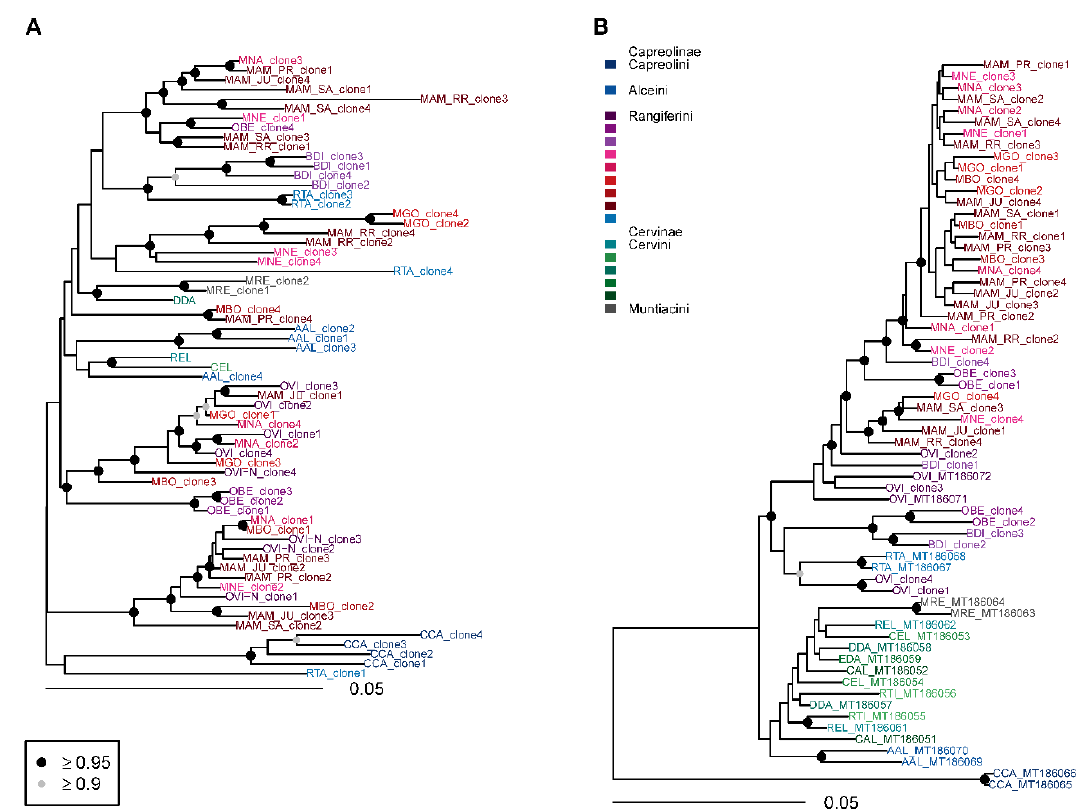
Figure 6. Bayesian phylogenetic trees constructed from cervid satellite sequences. ( A ) SatIII, ( B ) satIV. AAL— Alces alces , BDI— Blastocerus dichotomus , CAL— Cervus albirostris , CCA— Capreolus capreolus , CEL— Cervus elaphus , DDA— Dama dama , EDA— Elaphurus davidianus , MAM— Mazama americana , MBO— Mazama bororo , MGO— Mazama gouazoubira , MNA— Mazama nana , MNE— Mazama nemorivaga , MRE— Muntiacus reevesi , OBE— Ozotoceros bezoarticus , OVI— Odocoileus virginianus , REL— Rucervus eldii , RTA— Rangifer tarandus , RTI— Rusa timorensis . Circles at nodes signify nodes with posterior probability ≥ 0.95 ( black ) and 0.90 ( grey ). Unmarked nodes were not supported.